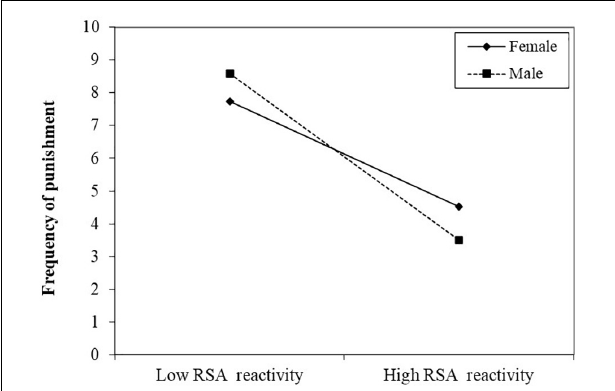
FIGURE 2 | Simple slope plots of RSA reactivity × gender on the frequency of punishment in third-party punishment task.